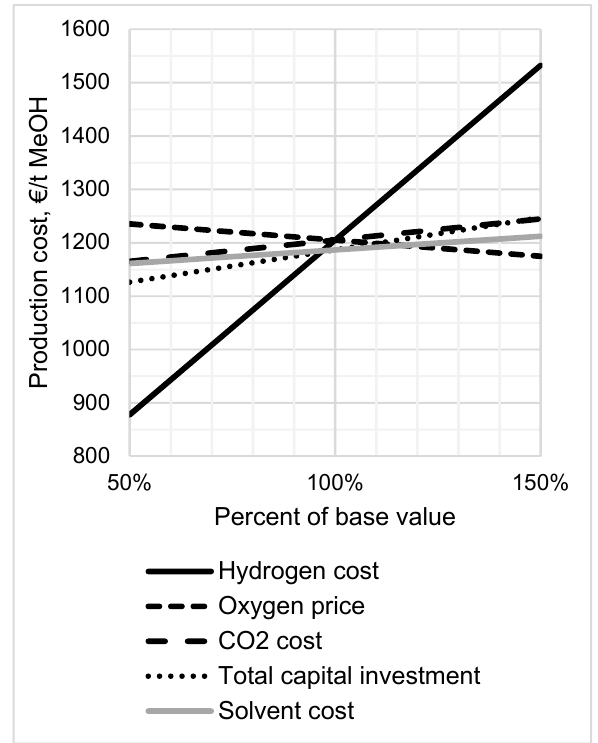
Figure 9. Sensitivity of methanol production cost to variations in selected parameters in the liquid-phase methanol synthesis process with 1-butanol solvent. Base values: hydrogen cost 3000 €/t, oxygen price 70 €/t, CO 2 cost 50 €/t, total capital investment 19.4 M€, solvent cost 500 €/t.